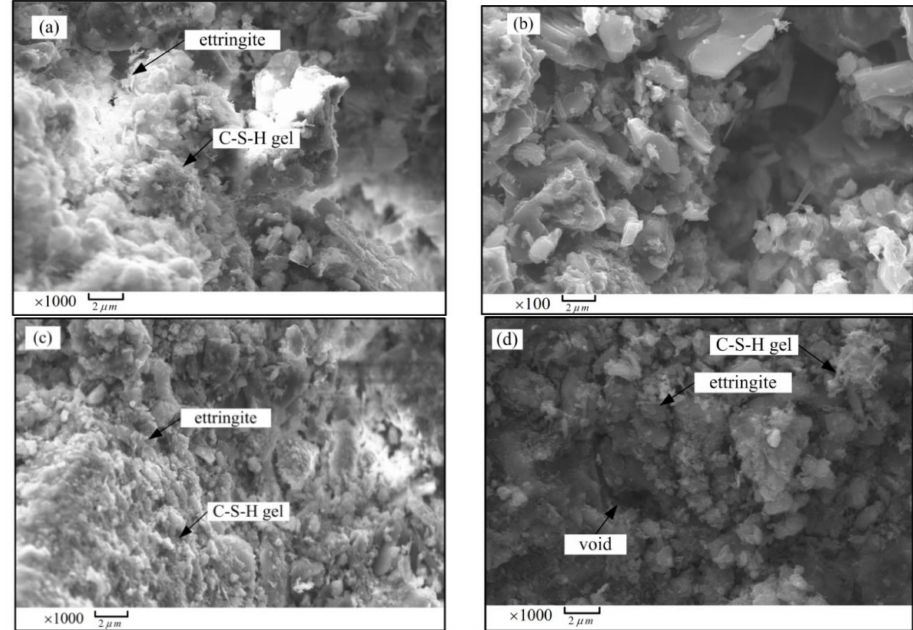
Figure 6. SEM micrographs showing cement backfill two sample textures. ( a , b ) Samples with 25 wt % of Portland cement; ( c ) Samples with 25 wt % of Binder B1; ( d ) Samples with 25 wt % of Binder